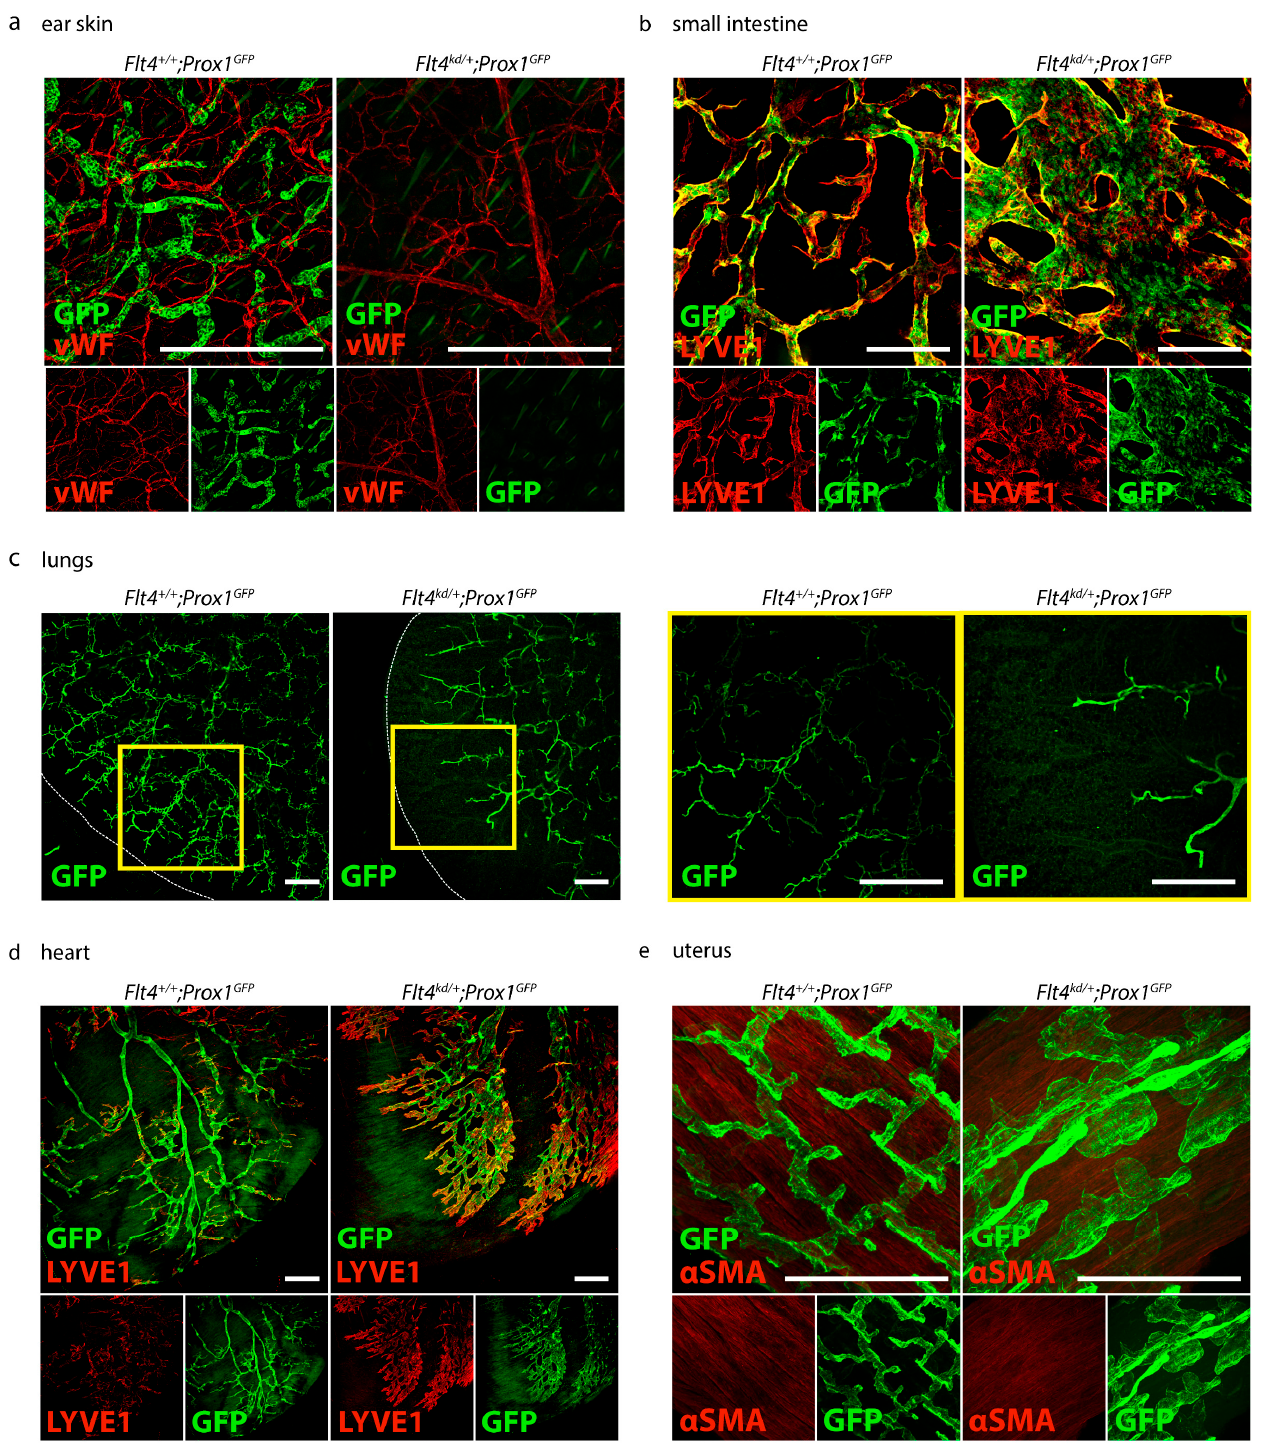
Figure 7. Visualization of the organ-specific lymphatic vasculature of Flt4 kd/+ mice. ( a ) Lymphatic vasculature of the ear skins of adult Flt4 +/+ ; Prox1 GFP and Flt4 kd/+ ; Prox1 GFP mice. Ears were stained with an anti-GFP antibody and anti-von Willebrand Factor (vWF). Images were acquired by confocal microscopy, scale bar 500 μ m (n = 5 ears of 5 mice per group). ( b ) Lymphatic vasculature of the small intestines of adult Flt4 +/+ ; Prox1 GFP and Flt4 kd/+ ; Prox1 GFP mice. Intestines were stained with an anti-GFP antibody and anti-LYVE1. Pictures were taken with confocal microscopy, scale bar 500 µ m (n = 6 small intestines of 6 mice per group). ( c ) Lymphatic vasculature of the lungs of adult Flt4 +/+ ; Prox1 GFP and Flt4 kd/+ ; Prox1 GFP mice. Lungs were stained with an anti-GFP antibody. Images